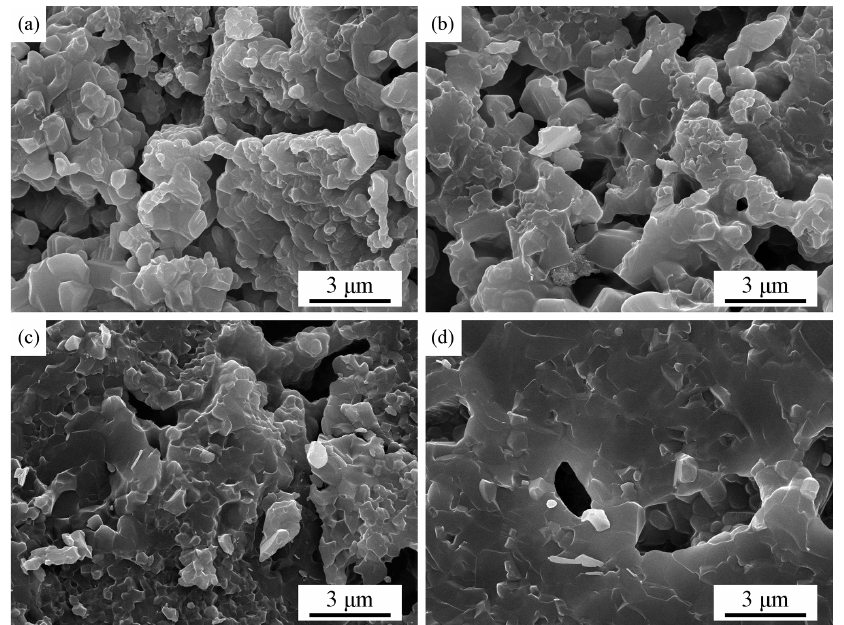
Figure 3: SEM micrographs of RB- β -SiAlON, (a) Z = 0.5, (b) Z = 1, (c) Z = 2, (d) Z = 3.